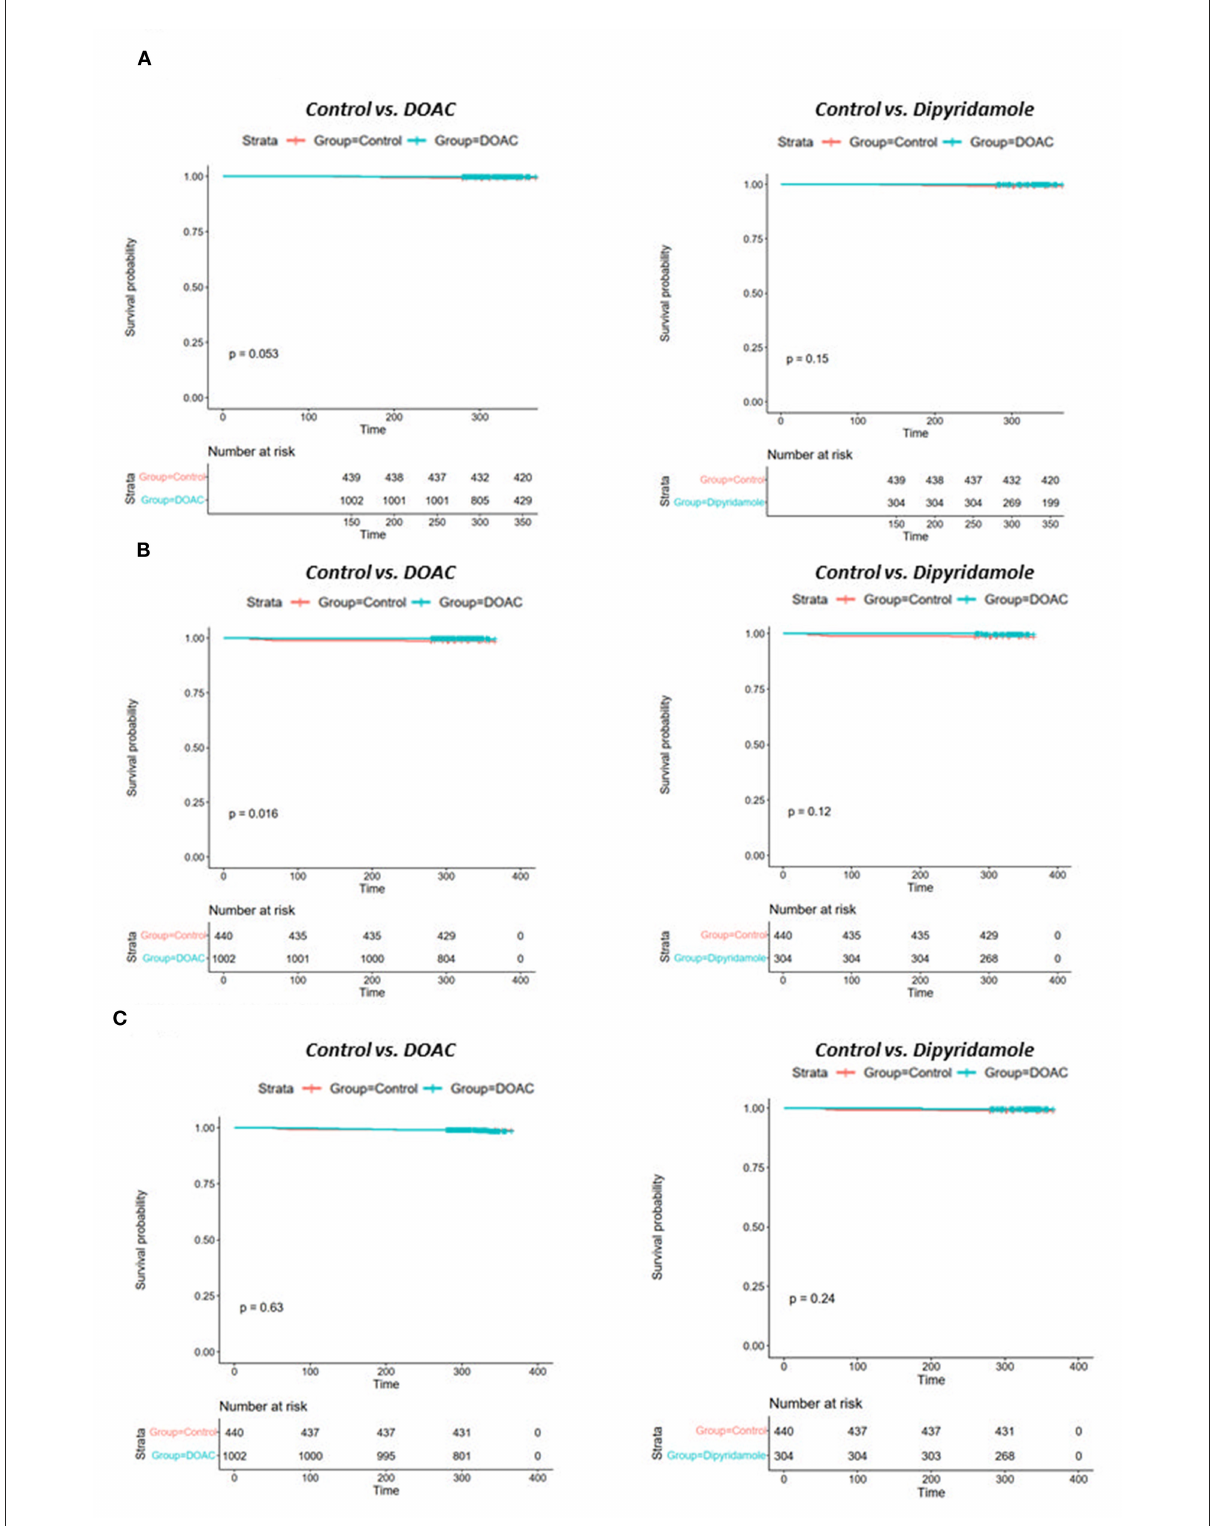
FIGURE5 Kaplan-Meier plots of (A) pulmonary embolism rates, (B) stroke rates and (C) myocardial infarction rates of controls vs. patients treated with DOAC and